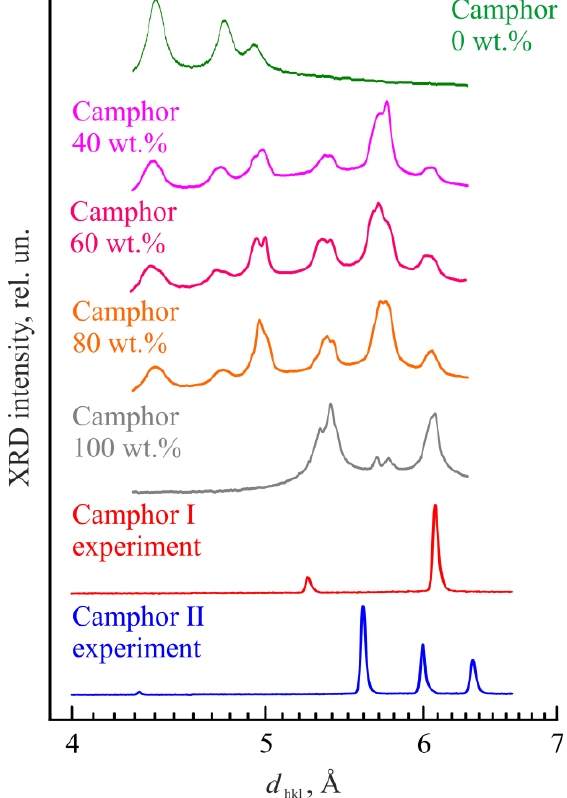
Figure 9. XRD patterns of camphor in the mixtures with PVDF of different compositions at room temperature (adapted from ref. [34]) and XRD patterns of pure camphor at 120 °C (phase I, fcc) and at room temperature (phase II, hex) obtained in this study.